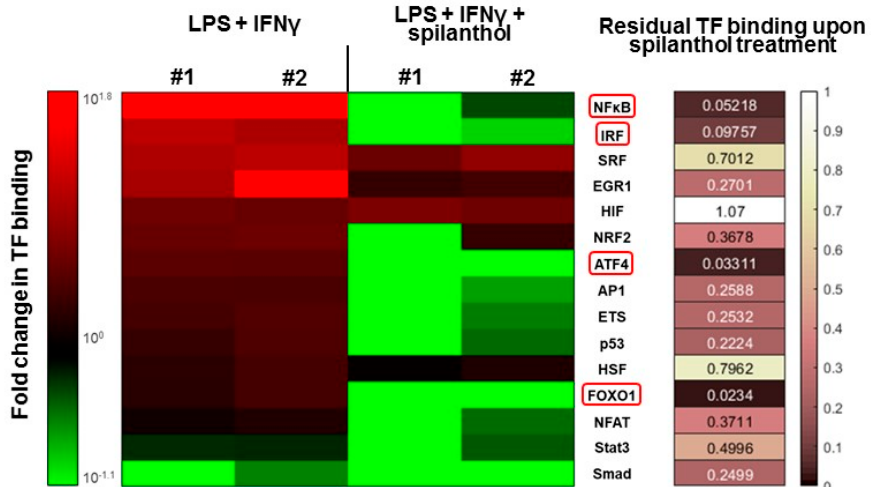
Figure 6. Spilanthol downregulates transcription factor pathways involved in inflammatory gene regulation. We tested the binding of 15 transcription factors to their cognate response elements in nuclear extracts of LPS + IFN γ and LPS + IFN γ + spilanthol treated cells by a transcription factor binding assay. The experiment was performed in duplicate (#1 and #2). The heatmap depicts the change of binding intensity of TFs compared to untreated cells. Binding comparable to that of the untreated cells is rendered in black, increased binding is shown in shades of red, and decreased binding in green, corresponding to the color bar. In the right panel, the level of residual TF binding after treatment with spilanthol is color-coded, so as darker colors denote increasingly pronounced inhibitory e ff ect by spilanthol and white denotes no e ff ect. We observed consistent downregulation in both experiments to ≤ 15% in the binding of NF κ B, IRF, ATF4, and FOXO1.